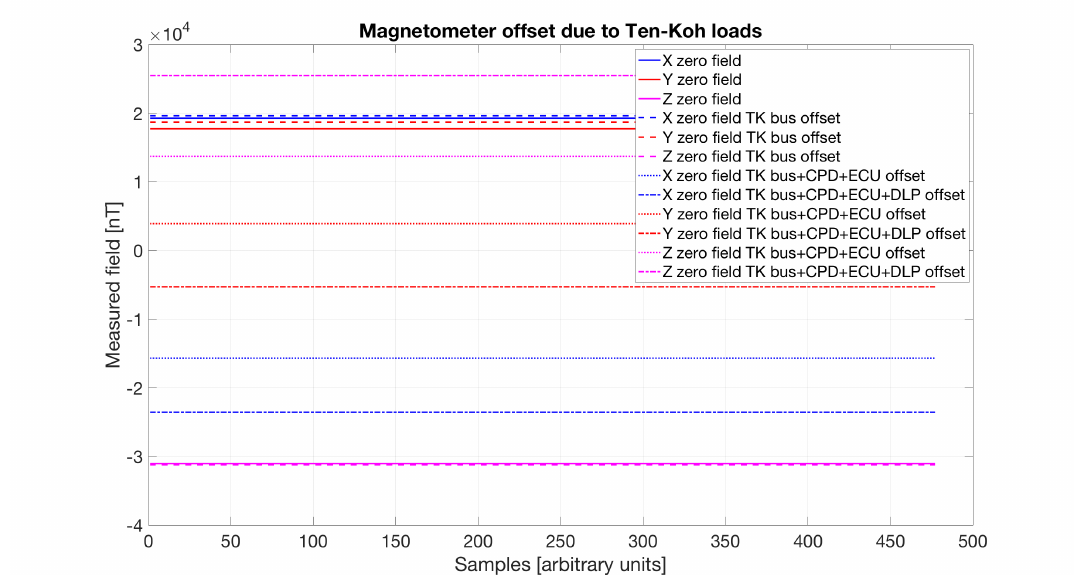
Figure 9. Magnetometer calibration tests. Offset imposed by the satellite to each axis when: no electronics are ON, and under specific subsystems operating conditions. The results will be used to remove the offset to the magnetometer measurements when the satellite is under specific operating